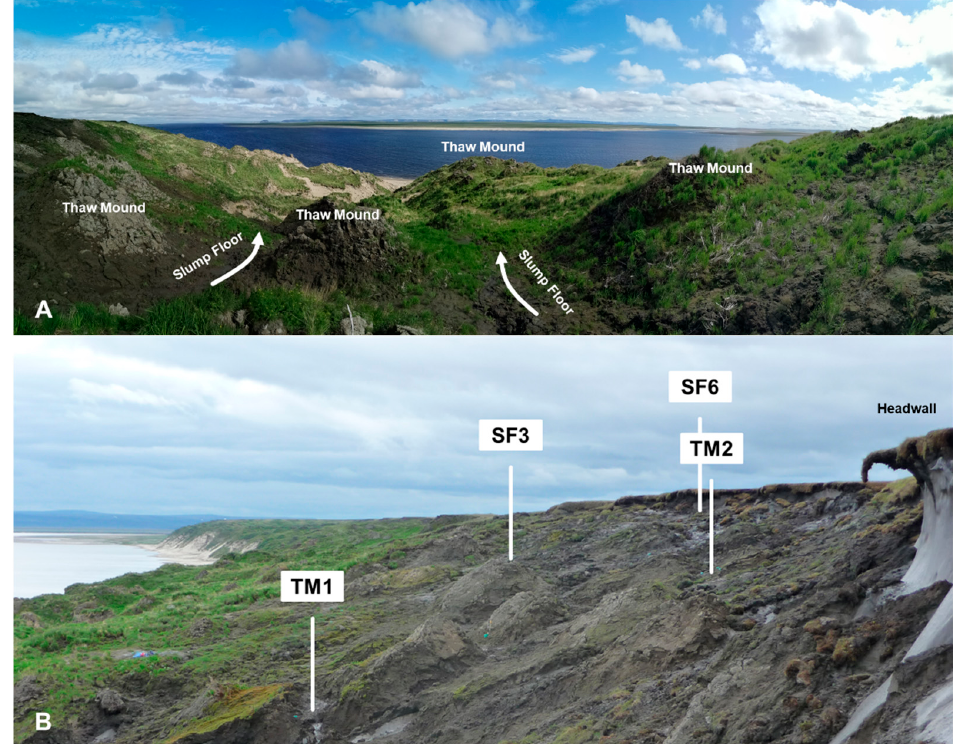
Figure 1. Studied retrogressive thaw slump on Kurungnakh: ( A ): Top–down view (2019) showing the slump floor (SF) and thaw mounds (TM) within the landscape. Thaw mounds are recognizable by their exposition from the SF. ( B ): Sample location within the slump (2016). The ice–rich headwall can be seen on the right site in the picture. Vegetation density increases with distance from the thaw front and hence time since thawing. Accordingly, sites SF6 and TM2 were more recently thawed than sites SF3 and TM1.